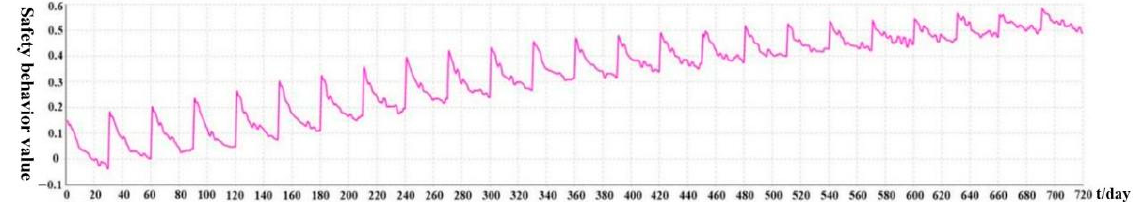
Figure 6. Variation trend of safety behavior over time under active intervention.